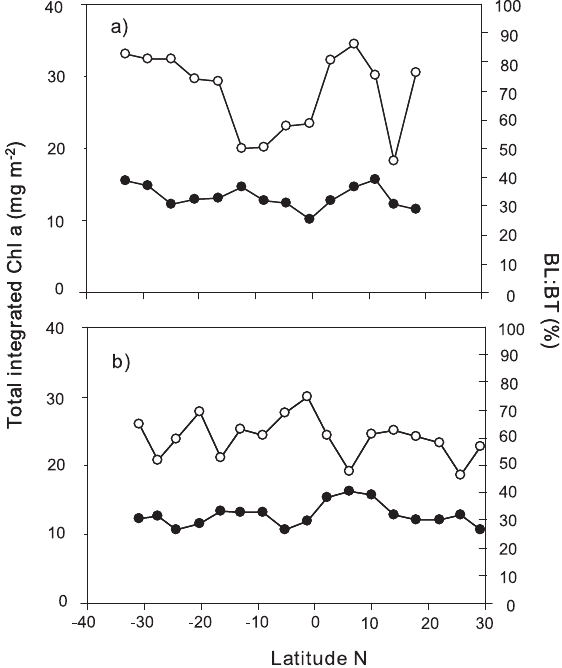
Fig . 4. – Latitudinal distribution of total integrated chl a (white circles, mg m -2 ) and the relative contribution of phytoplankton >2 m m to total integrated chl a (BL:BT, black circles, %). a) Trynitrop 2007; b) Trynitrop